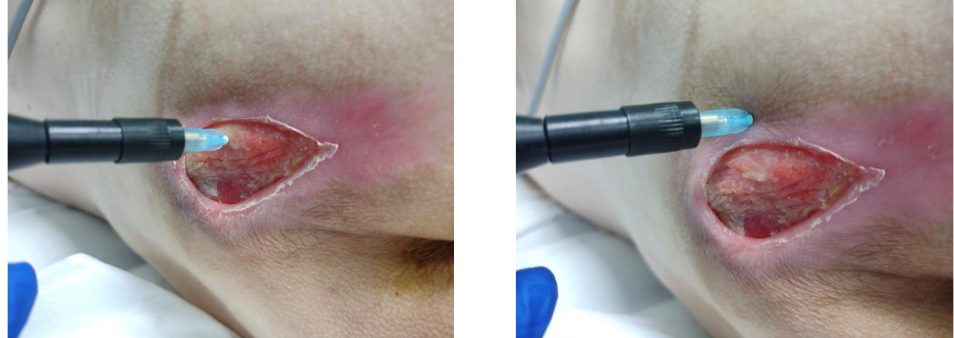
Figure 4. Technique for the treatment of pressure sores by the method of activation by LTP dis- charges.